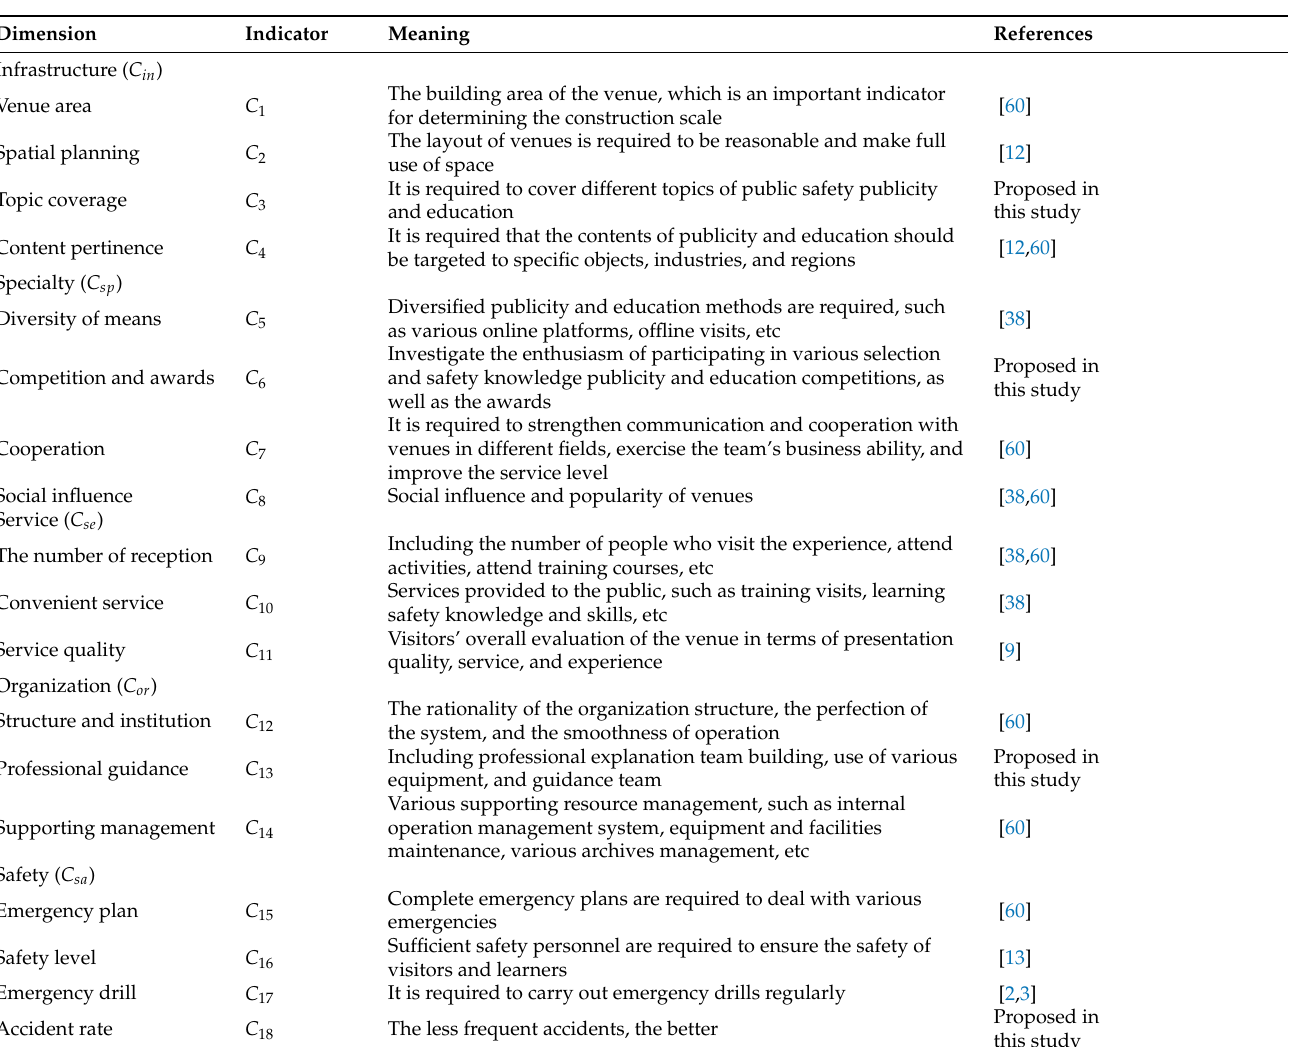
Table 1. The comprehensive index system for assessing public safety education